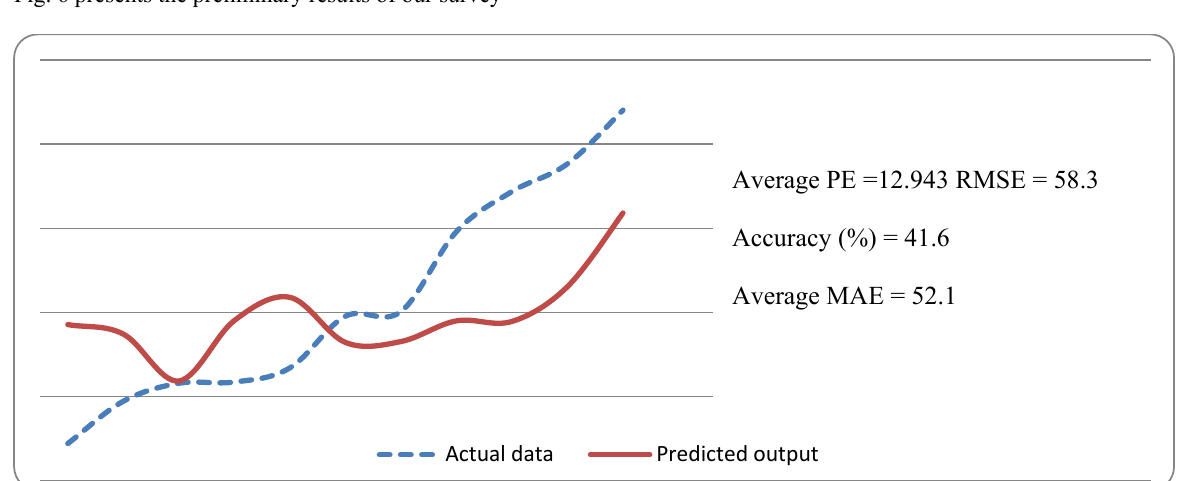
Fig. 6. Actual values vs. predicted values (Primary model –Middle